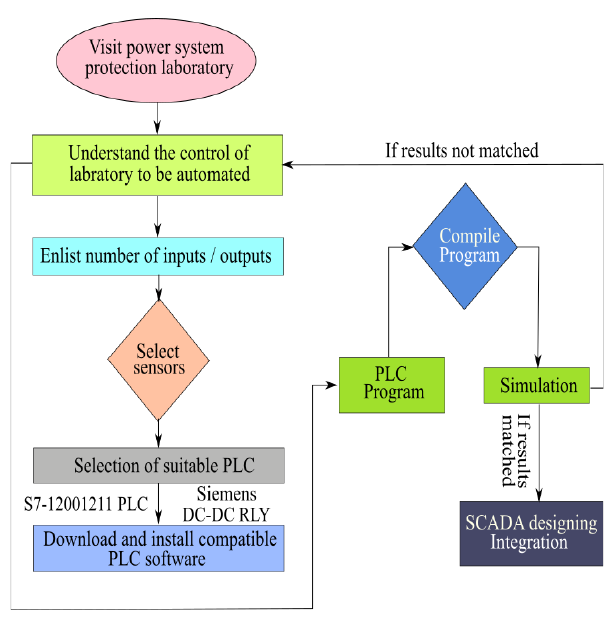
Fig. 1. Flow chart for the proposed